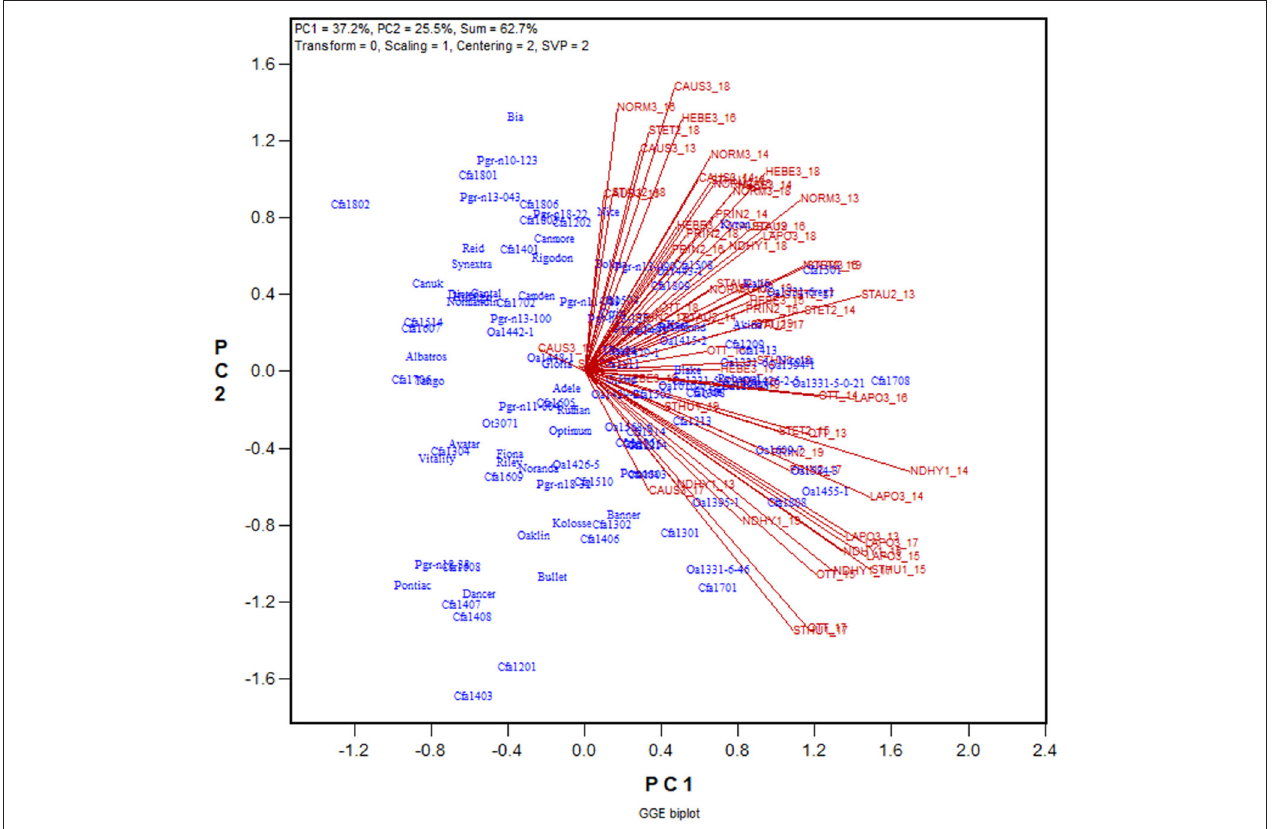
FIGURE 3 | GGE biplot to show the relative yield of 116 oat genotypes in 67 trials from the 2013–2019 Quebec provincial oat trials. The genotypes are displayed in blue and the trials in red. Each trial is displayed as a location-year combination. The Quebec locations are: NDHY1 (St Hyacinthus) and STHU1 (St. Huber) in Zone 1, PINT2 (Pintendre), PRIN2 (Princeville), STAU2 (St. Augusta), and STET2 (St. Etienne) in Zone 2, and NORM3 (Normandin), CAUS3 (Causapscal), HEBE3 (Hebertville), and LAPO3 (La Pocatière) in Zone 3. OTT (Ottawa) is a location in Ontario. PC1 and PC2 are the first two principal components from singular value decomposition of the trial-standardized yield data (“Scaling 1,” “Centering 2”), with the singular values fully partitioned to the trial scores (“SVP 2”) for proper visualization of the = = = correlations among trials.